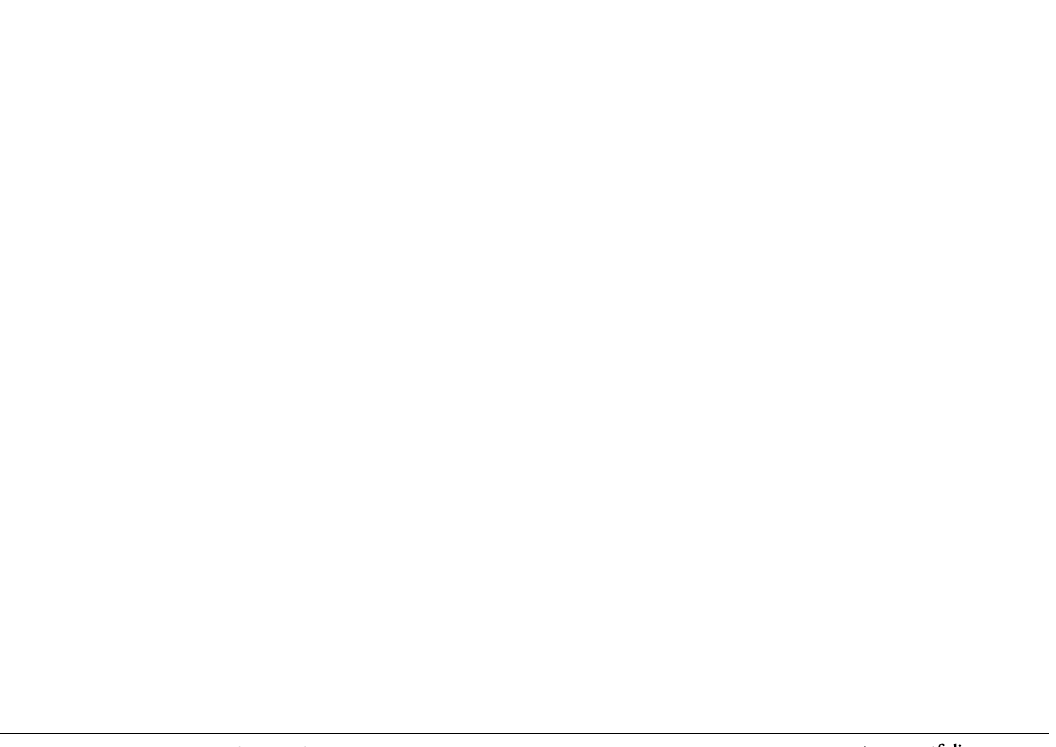
Figure 15. ( a ) 3D plot and ( b ) contour plot showing effect of concentration and adsorbent mass on percentage adsorption of cobalt(II) ions (pH = 4; time = 130